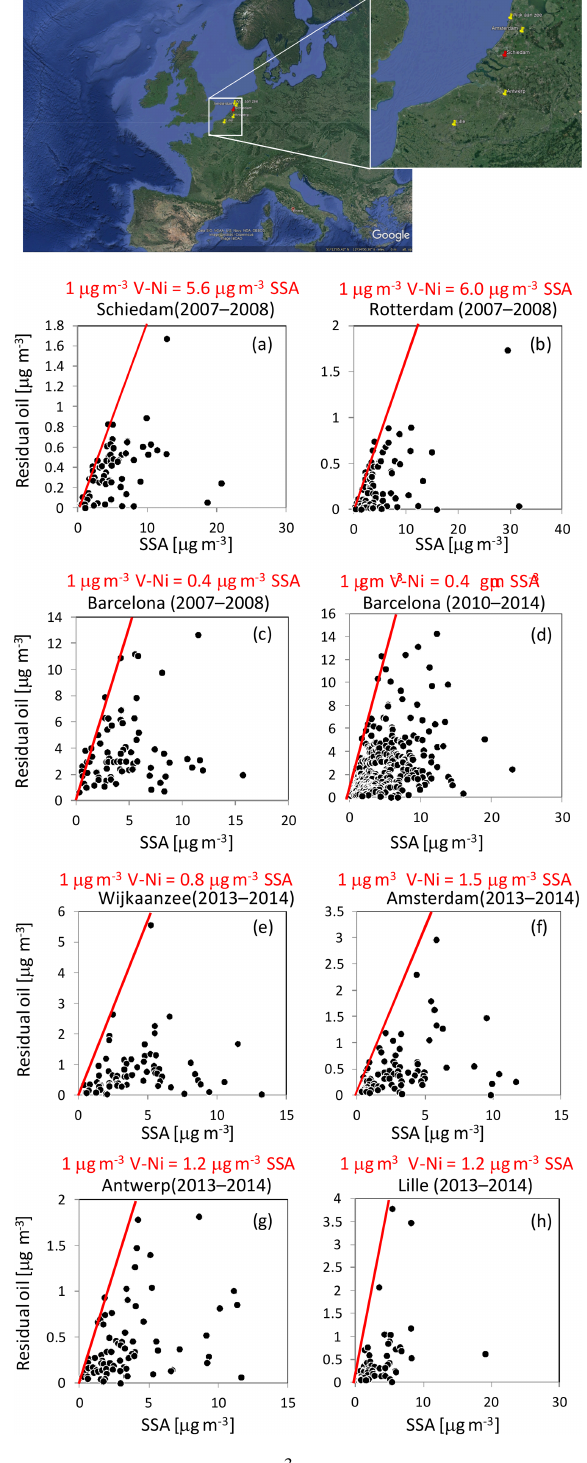
Figure 4. Contributions (µgm − 3 ) of the V- or Ni-bearing particles from shipping and SSA particles to PM at Schiedam (a) , Rotter- dam (b) , Wijk aan Zee (e) and Amsterdam (f) in the Netherlands and Barcelona ( c and d , Spain), Antwerp ( g , Belgium) and Lille ( h , France). The red lines represent the edges of the scatter plots. © Google